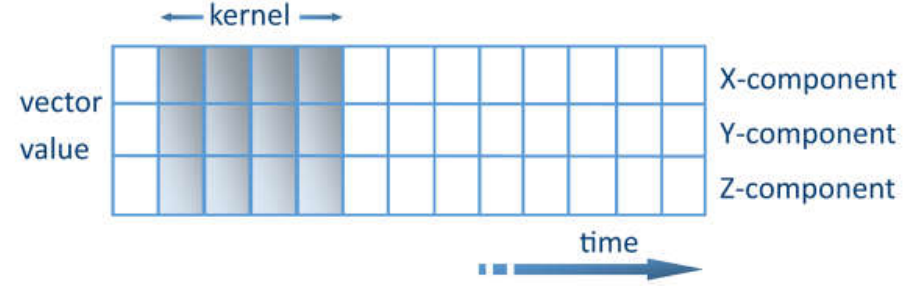
Figure 3. Representation of the kernel with 3D vector quantity.